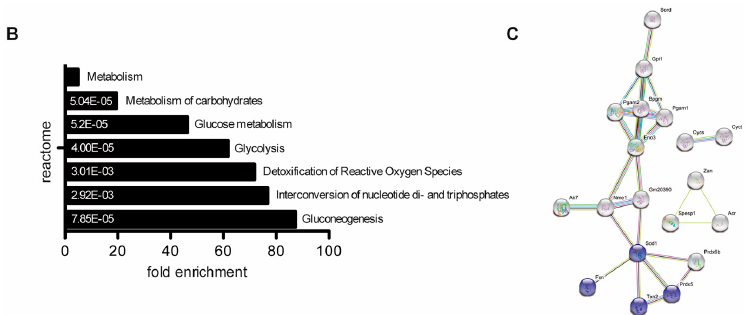
Figure 2. The molecular function of deregulated proteins in Prm2 -deficient sperm. ( A ) Volcano plots displaying DE proteins in pairwise comparison of Prm2 +/+ (WT), Prm2 +/ − (HET) and Prm2 − / − (KO) samples. ( B ) Reactome pathway analysis of proteins downregulated in Prm2 - / - sperm compared to wildtype ( | log 2 FC | > 1; FDR < 0.1). FDR is given in each bar. ( C) STRING analysis of proteins downregulated in Prm2 − / − sperm compared to wildtype ( | log 2 FC | > 1; FDR < 0.1). Proteins involved in biological processes of hydrogen peroxide metabolism are highlighted in